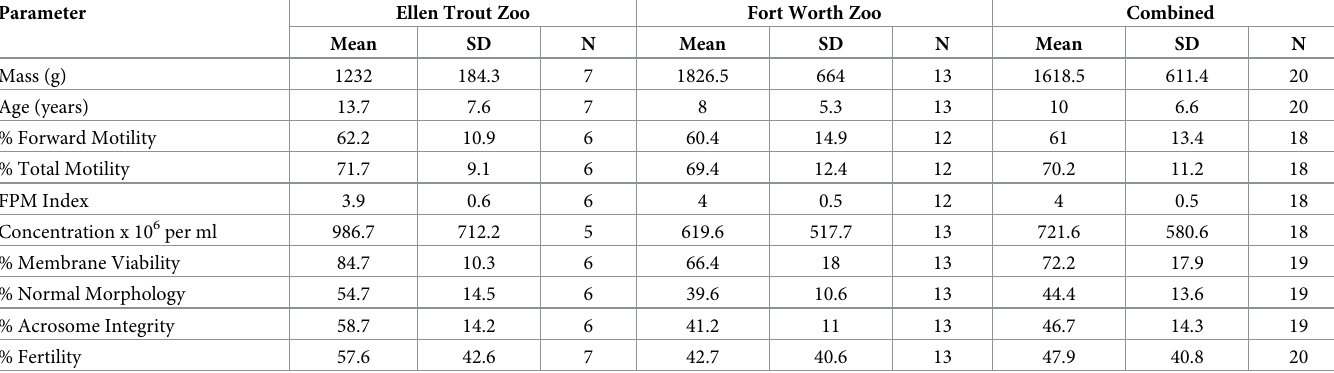
Table 1. Summary table of male traits and fertilization rate of pairings from assessments of 20 captive breeding Louisiana pinesnakes. Parameter Ellen Trout Zoo Mass